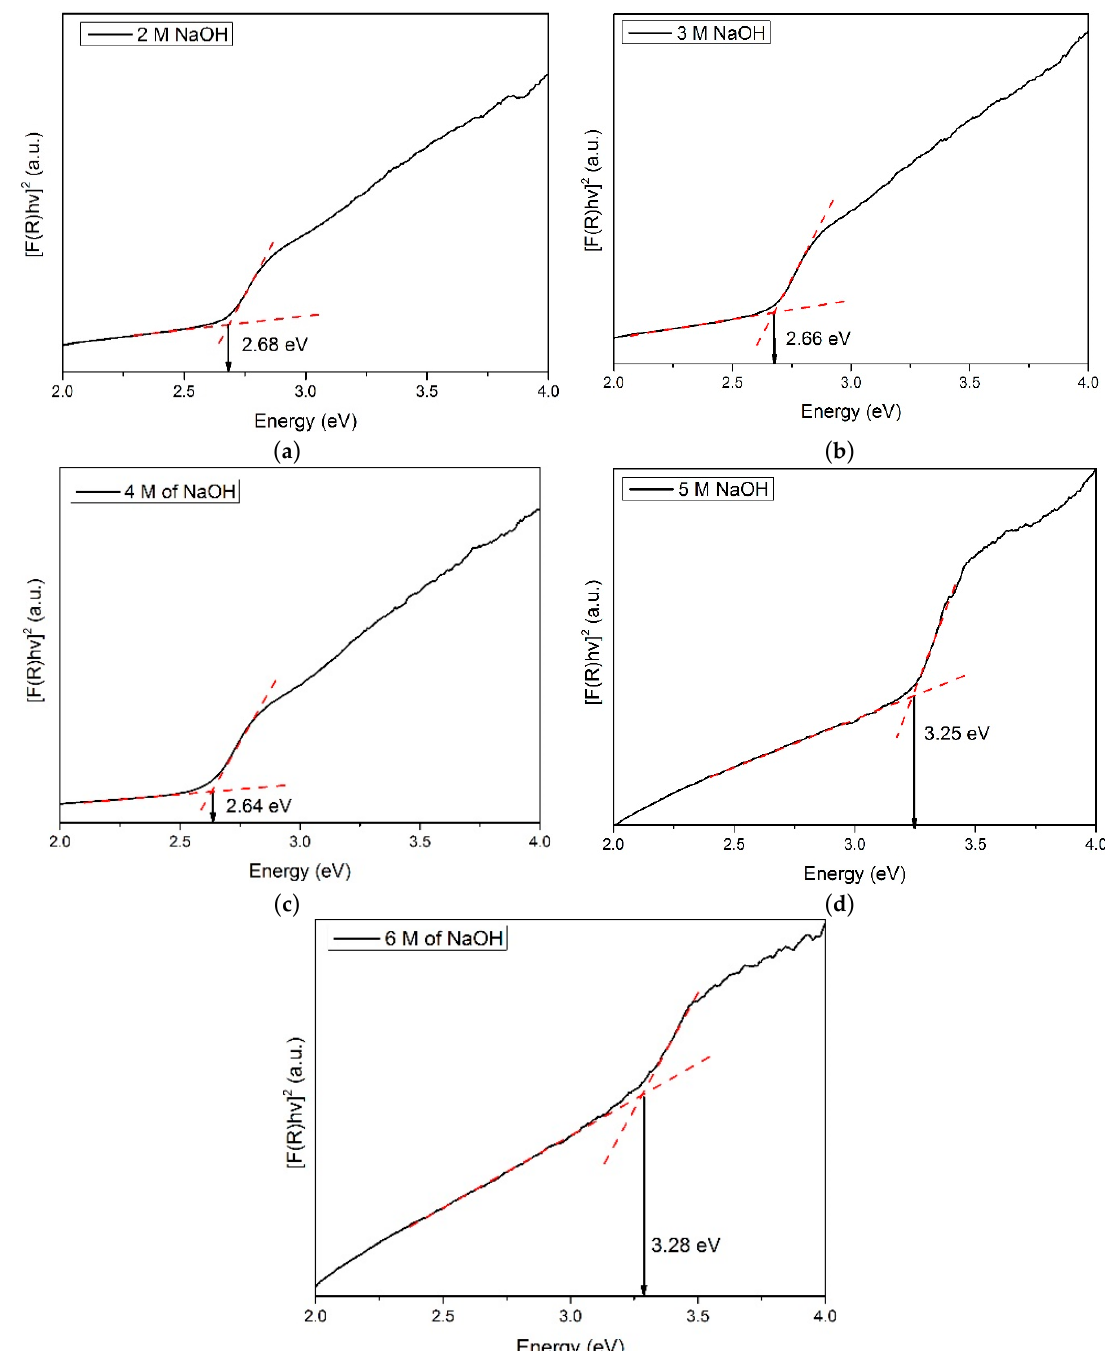
Figure 4 . Kulbeka–Munk approach for samples synthesized with ( a ) 2 M, ( b ) 3 M, ( c ) 4 M, ( d ) 5 M, and ( e ) 6 M of NaOH.